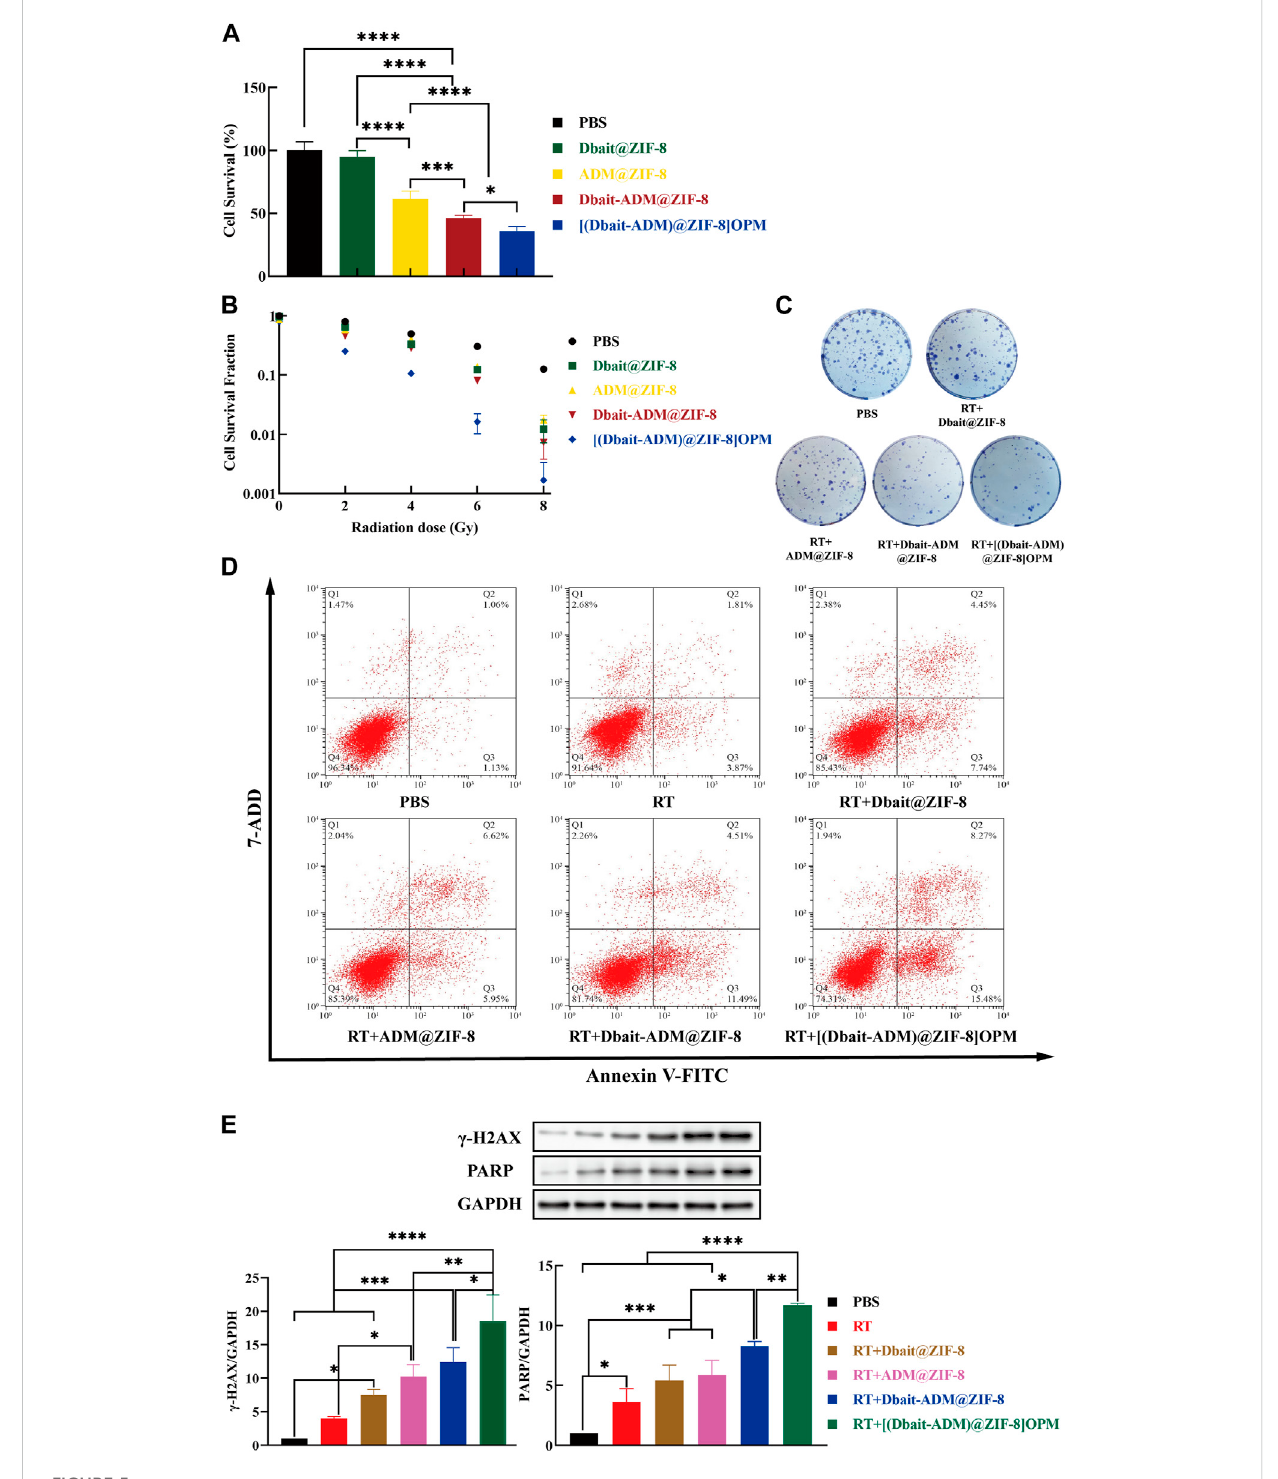
FIGURE 5 Invitro antitumoref fi cacyof[Dbait-ADM@ZIF-8]OPM. (A) TheeffectofPBS,Dbait@ZIF-8,ADM@ZIF-8,Dbait-ADM@ZIF-8,and[Dbait-ADM@ZIF-8] OPM on the survival of SaOS-2 cells was detected by CCK-8 assay. (B) Under the condition of different doses of RT, the effect of each group on the proliferation of SaOS-2 cells was detected by colony formation assay. (C) The colony formation of SaOS-2 cells in different treatment groups under 2 Gy conditions. (D) PBS, Dbait@ZIF-8, ADM@ZIF-8, Dbait-ADM@ZIF-8, and [Dbait-ADM@ZIF-8] OPM induced apoptosis in SaOS-2 cells induced by 2 Gy RT. (E) Western blot analysis of γ -H2AX and PARP protein levels in SaOS-2